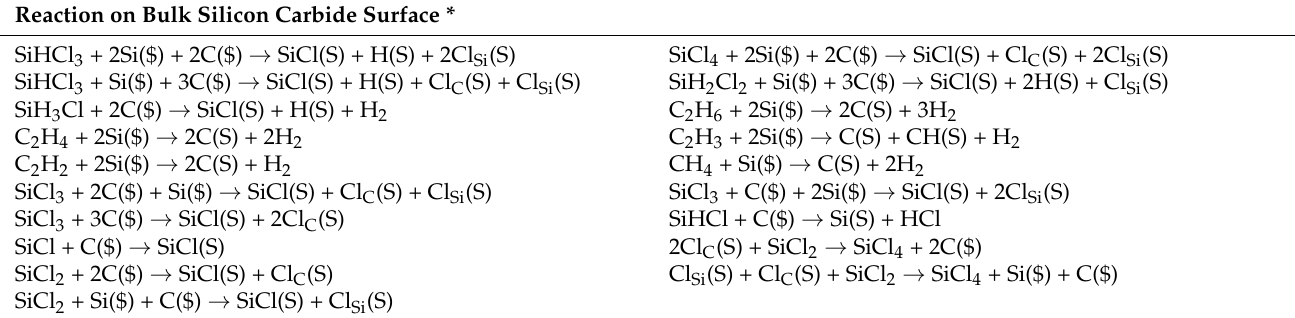
Table 2. List of surface reactions in which C or Si contained intermediate species participate as reactants from references [12,17].